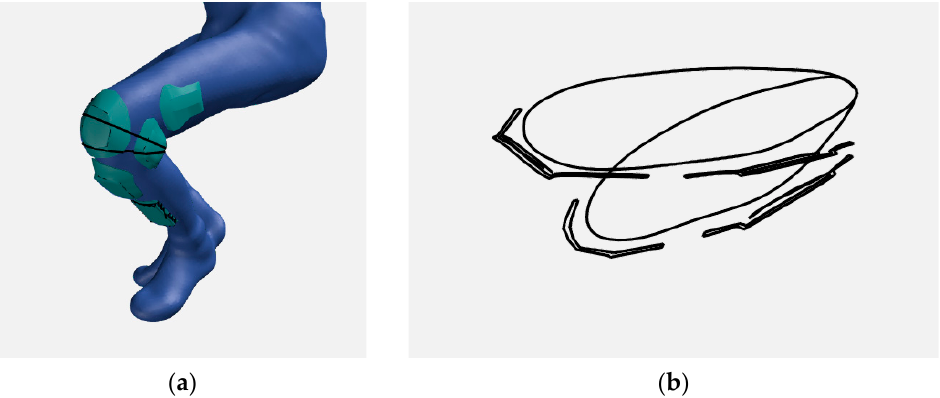
Figure 6. Defining the intersection of the protector and knee ( a ); Defining the comfort and adherence of the 3D printed element and knee ( b ).